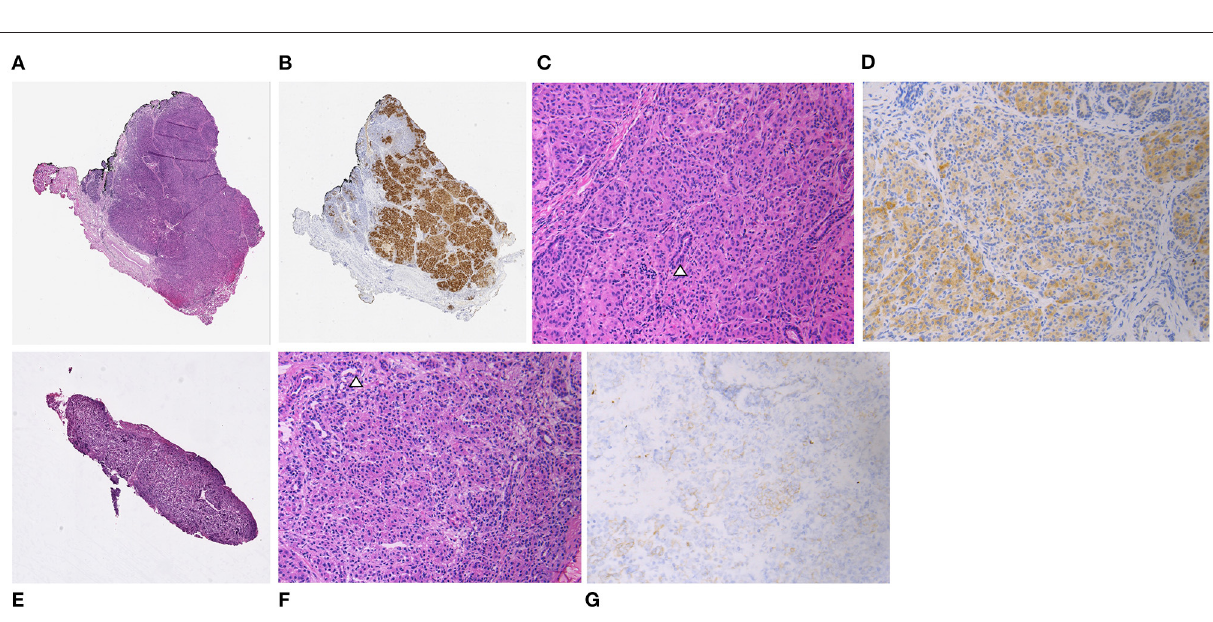
FIGURE 2 | Patient 1. Focal lesions from the pancreatic head [ (A) hematoxylin and eosin [H&E], (B) chromogranin immunohistochemical stain [IHC], both at x20 original magnification] and body [ (E) H&E, x20 original magnification] composed of localized increases in endocrine tissue with occasional ducts (arrowhead) [ (C,F) H&E, x200 original magnification]. Endocrine cells demonstrate loss of nuclear immunoreactivity for p57 in both lesions with non-specific reactivity within the cytoplasm [ (D,G) p57 IHC, x200 original